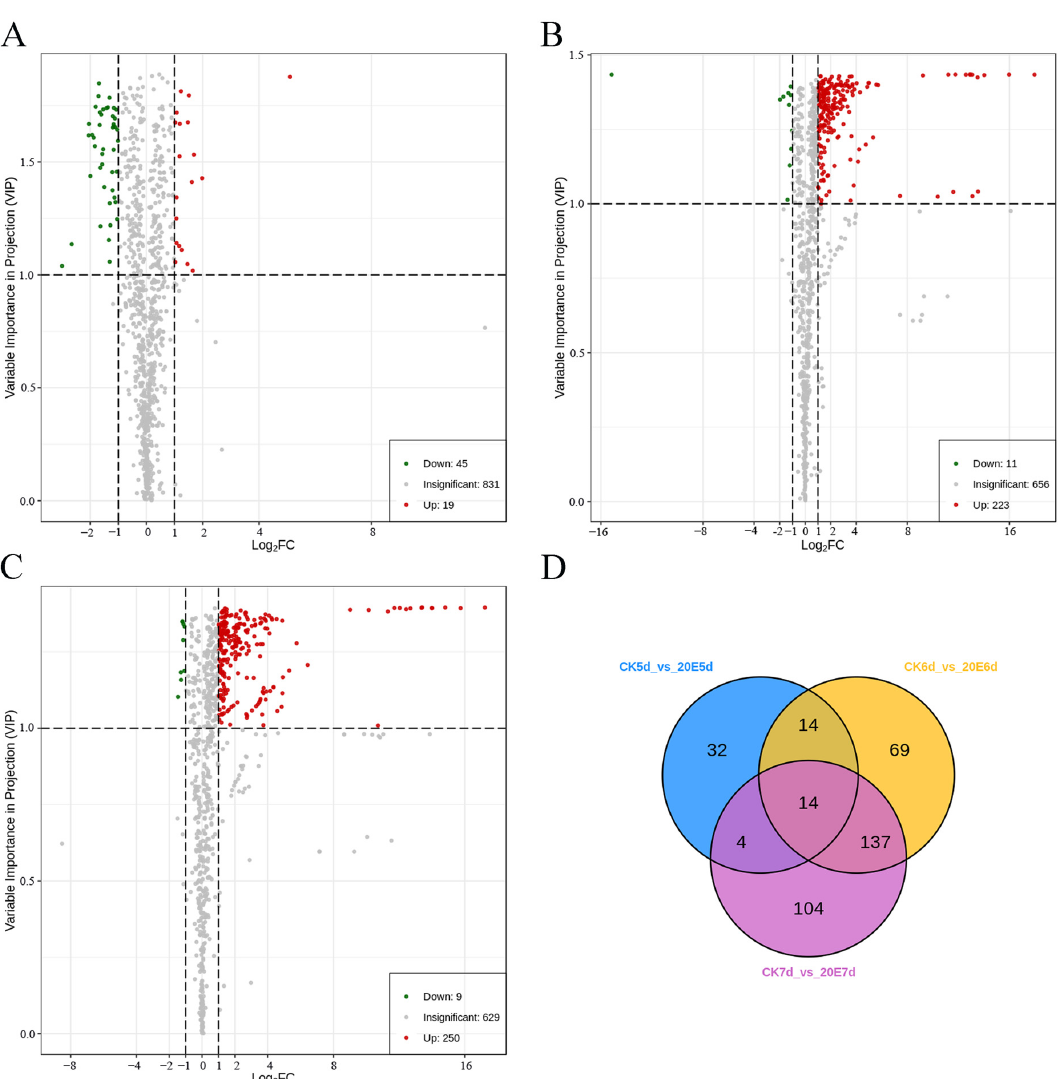
Figure 3. Volcano plot of the differential metabolites of ( A ) CK-5d vs. 20E-5d; ( B ) CK-6d vs. 20E-6d; ( C ) CK-7d vs. 20E-7d. ( D ) Venn diagram of the differential metabolites of CK-5d vs. 20E-5d, CK-6d vs. 20E-6d and CK-7d vs. 20E-7d. Numbers represent the identified differential metabolites of the pairwise